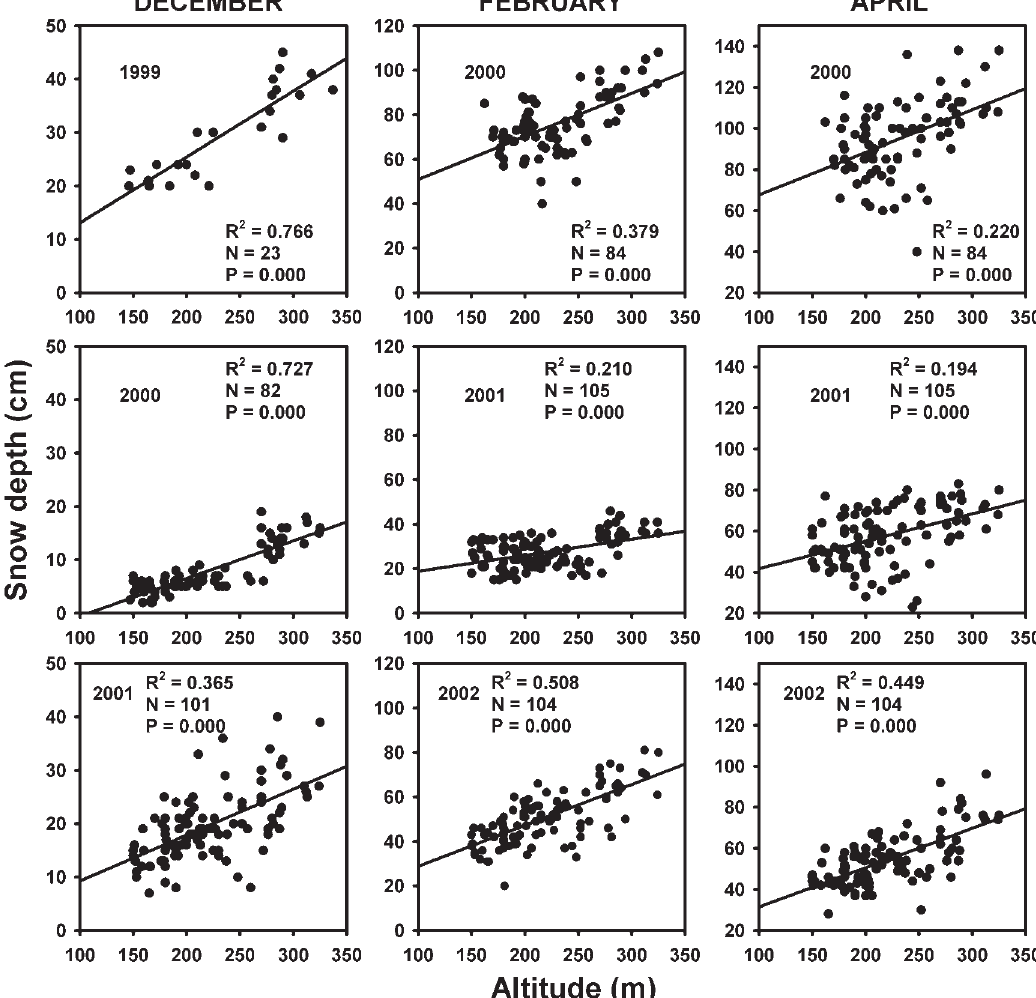
Fig. 4. Dependence of snow depth (cm) on altitude (m a.s.l.) in different months in the Ivalo reindeer herding district during winters 1999 - 2002. Simple regression